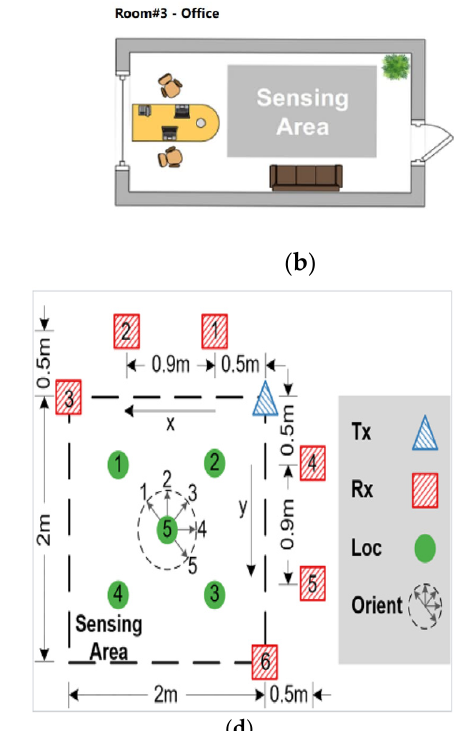
Figure 9. The picture above shows the experimental environment and Gesture drawing direction: ( a ) Hall; ( b ) Office; ( c ) Classroom; ( d ) Gesture drawing direction.